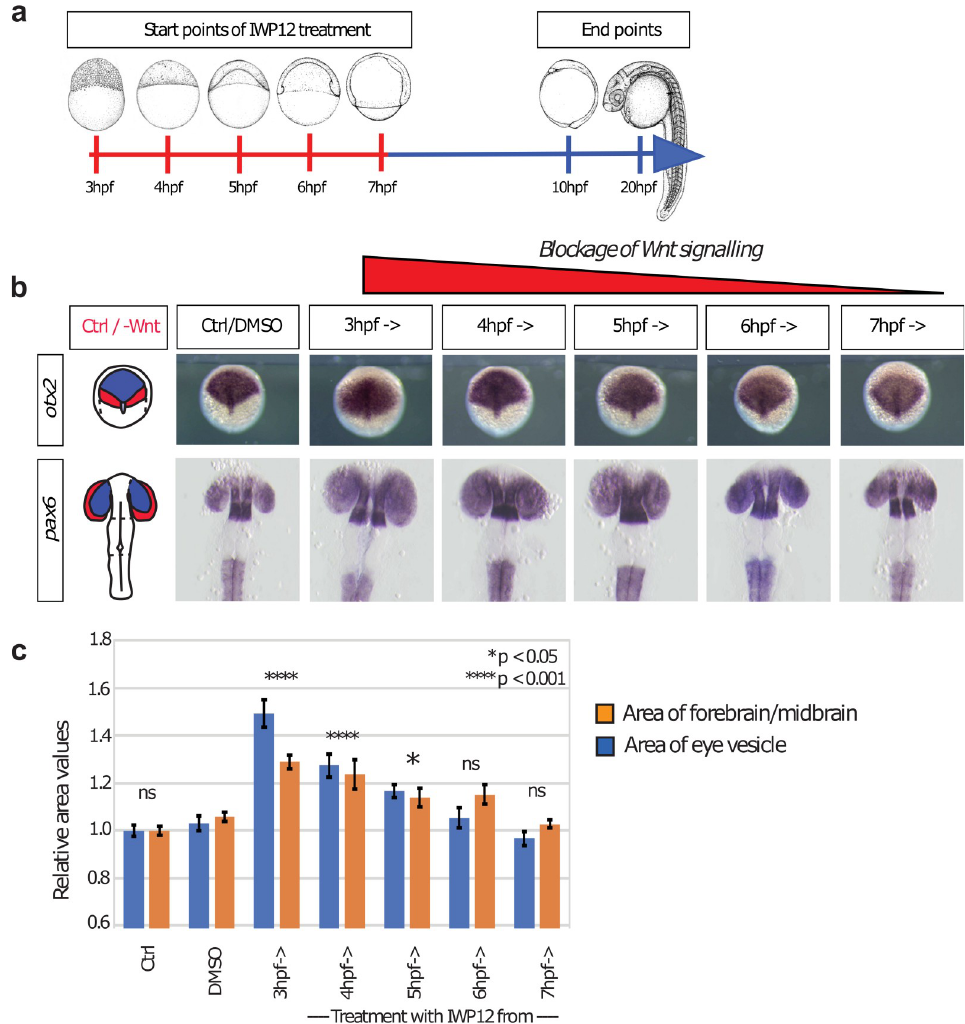
Fig 7. Wnt/ β -catenin signaling influences anteroposterior patterning of the neural plate during early gastrulation. To determine the temporal function Wnt/ β -signaling on patterning, zebrafish embryos are treated with 5 μ M of the Porcupine inhibitor IWP12 to block Wnt secretion. a) Treatment started at different time points (3–7 hpf) until 10 hpf. At 10 hpf and 20 hpf, embryos are fixed and subjected to ISH against otx2 and pax6a , respectively. b) Embryos treated from 3 hpf and 4 hpf to 10 hpf showed a significant increase of the forebrain and midbrain tissue at 10 hpf and an enlarged area of the eye vesicle at 20 hpf. c) Embryos treated after this time point showed only marginal changes in patterning, suggesting that Wnt signaling is required between 3–5 hpf to pattern the neural